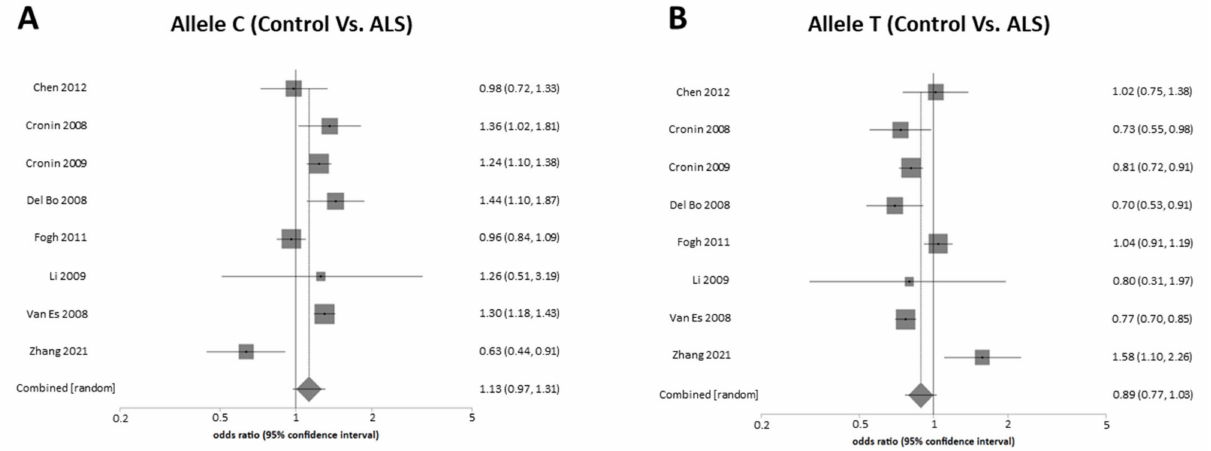
Figure 3. Forest plots reported no significant associations between single-nucleotide polymorphisms (SNP rs10260404) and risk of allele (C > T) of sporadic amyotrophic lateral sclerosis (SALS) from meta-analyses. Despite not being significant, the C allele points to a marked ALS risk ( A ) compared to the T allele ( B ). The square size indicates the weight of each study and pooled data, together with odds ratio and 95% confidence interval Odds ratio meta-analyses for the difference between alleles from control and SALS cases [21,29,30,38,41,46–48].